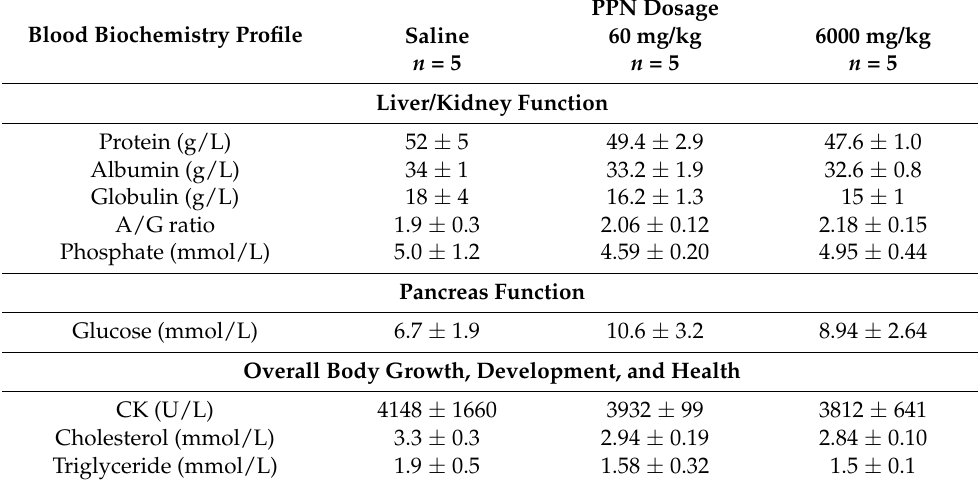
Table 3. Blood biochemical serum parameters of BALB/c mice 14 days following a single IV ad- ministration of PPN (acute-dose toxicity) on selected. The data are expressed as mean ± standard deviation ( n =